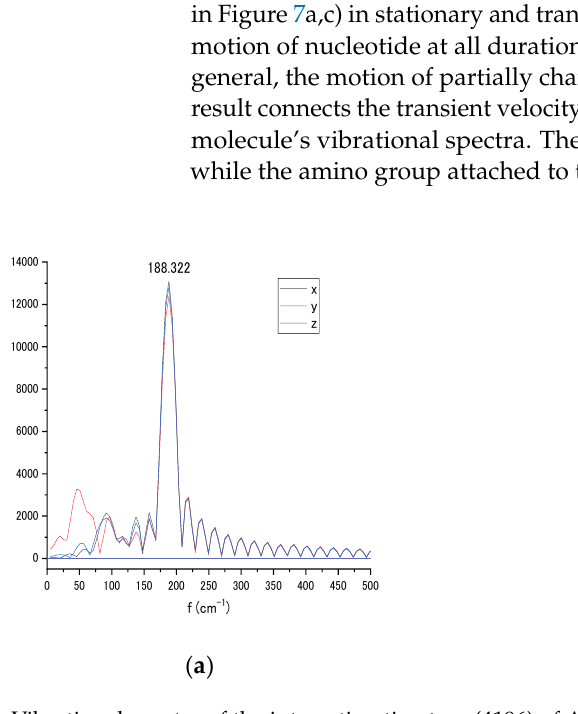
Figure 9. Vibrational spectra of the interacting tip atom (4196) of Au 20 nanoparticle in x, y, and z coordinates at initial ( a ) and rotated ( b ) orientation relative to cytosine localization.